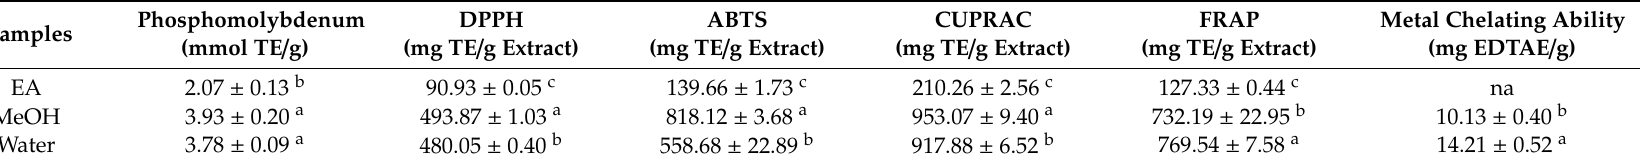
Table 4. Antioxidant activities of the tested